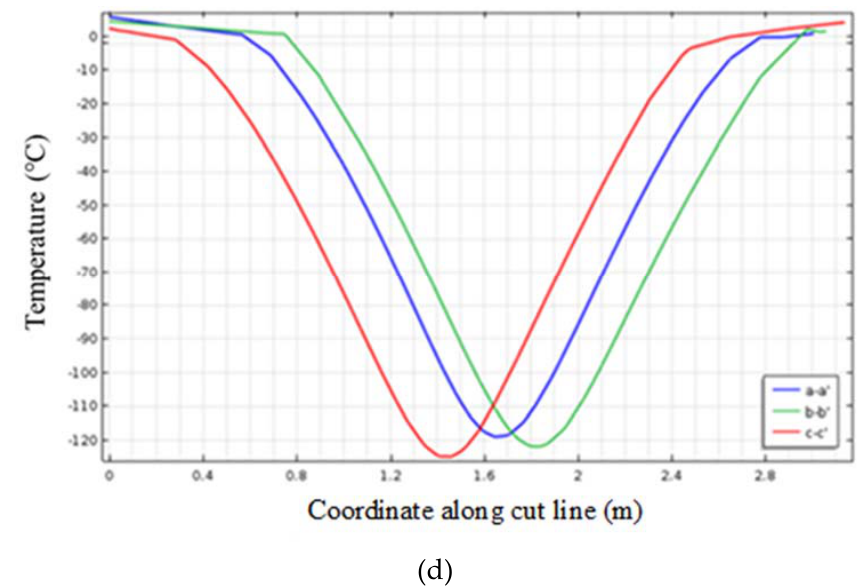
Figure 18. The frozen wall after 14 days of nitrogen feeding for section A ‐ A (a); for section B ‐ B (b); for section C ‐ C (c); Temperature profile for section C ‐ C (d).